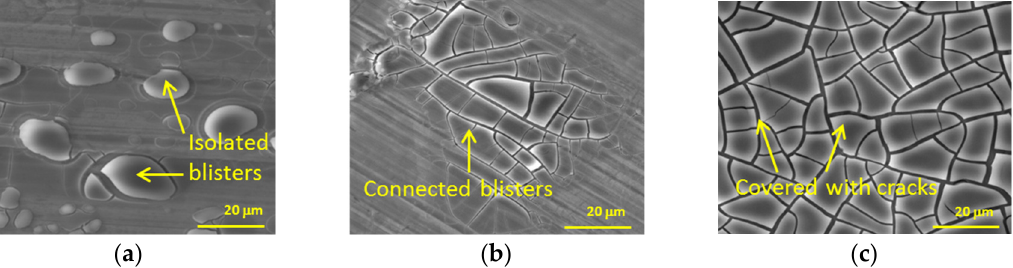
Figure 2. E ff ect of ratio of 1-Ethyl 3-Methyl Imidazolium Chloride ([EmIm]Cl) to AlCl 3 on the morphology of oxide film: ( a ) ratio = 1:0.5, ( b ) ratio = 1:1, ( c ) ratio = 1:1.5.